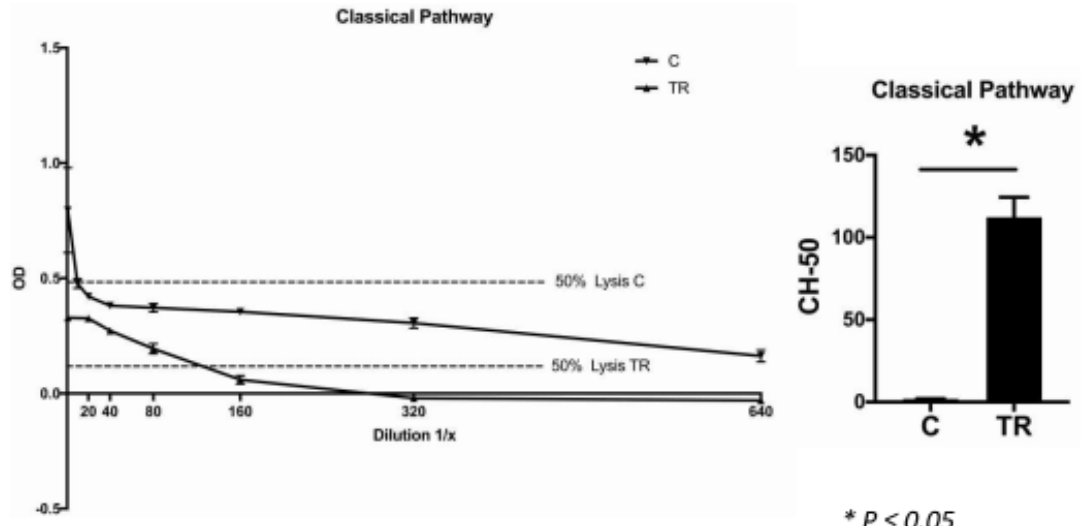
Figure 6. ( A ) Immunohistochemical staining of complement factor C3 in the gingiva of the controls (C) ( n = 4) and cats affected by gingivitis (G) ( n = 6), periodontitis (PD) ( n = 9) or tooth resorption (TR) ( n = 12). Images were obtained at 400× magnification. In the control and gingivitis groups, no positively stained cells were observed. Two C3-positive cells were seen in periodontitis, marked by black arrows. The greatest number of positively stained cells could be observed in TR. ( B ) There was a statistically significant increase in C3-positive cells in the TR group compared with the other three groups ( p ≤ 0.05). ( C ) Double immunofluorescence staining in the gingiva of a tooth affected by TR. Scale bar 50 μm. Mast cell granules (Avidin) were stained red, while C5 was stained green. In this section, one mast cell was positive for C3, marked by a white arrow.